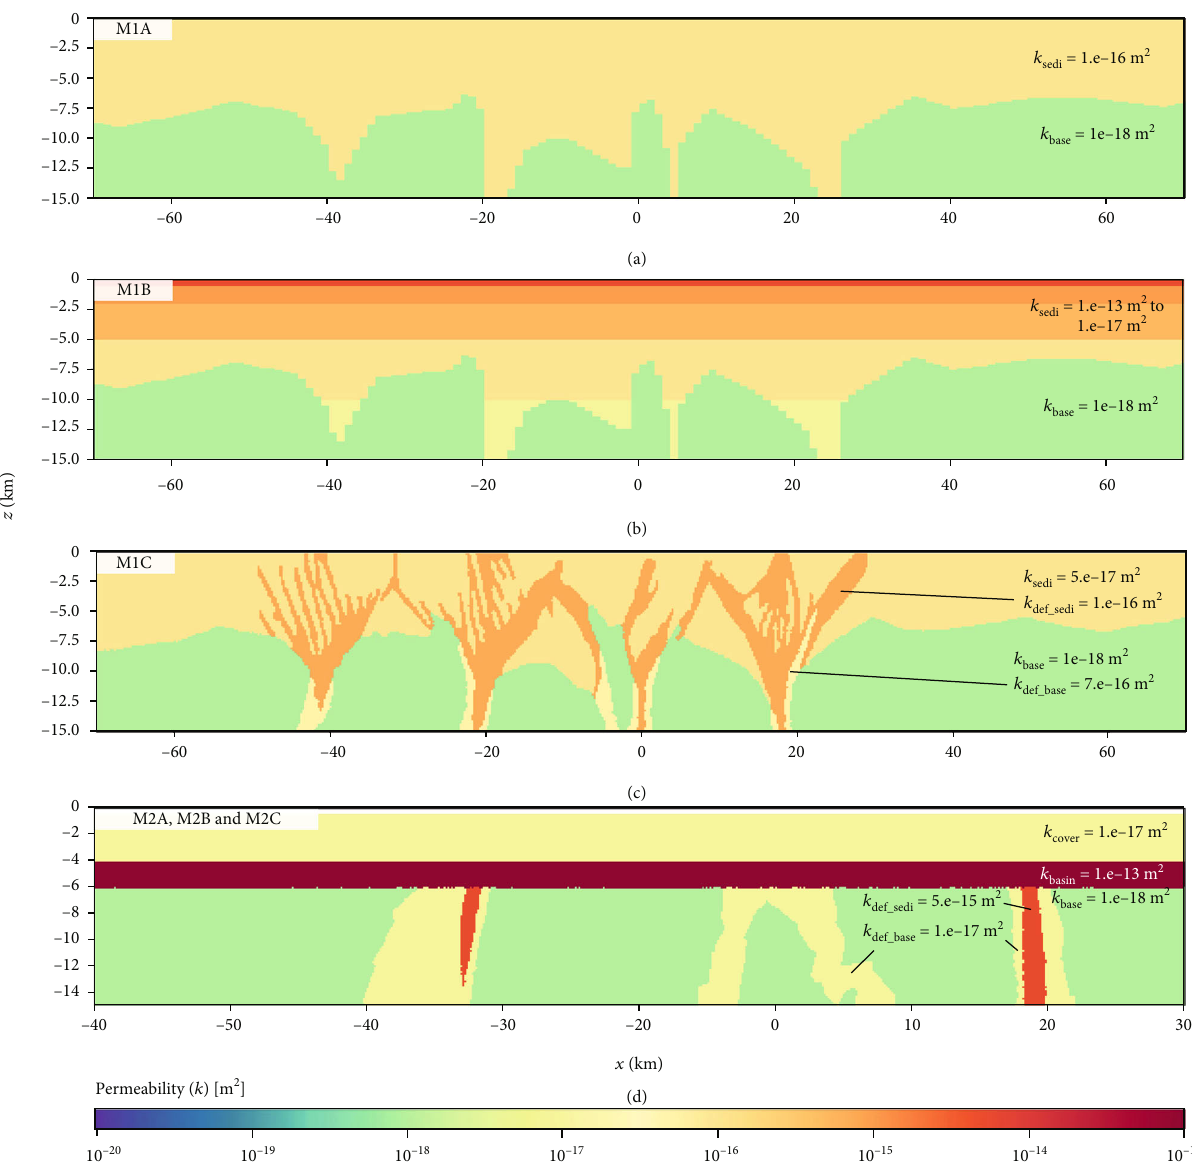
Figure 3: Permeability con fi gurations for two types of models: M1 and M2. Model M1 has three permeability con fi gurations denoted as (a) M1A, (b) M1B, and (c) M2C. Permeability con fi guration for models (c) M2A, M2B, and M2C remains the same. Details regarding permeability setups for models are found in Table 1 and Section